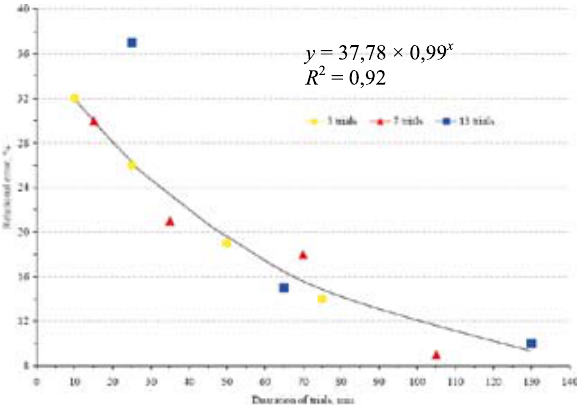
fig. 5. Interactive window for the input of traffic